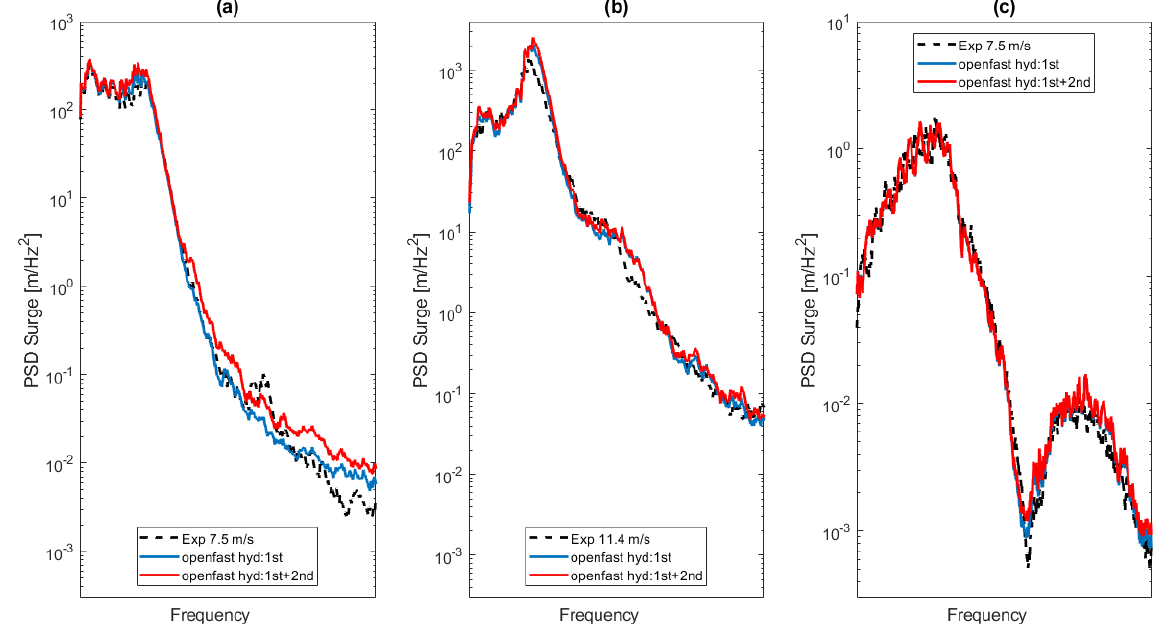
Figure 11. Surge PSD response of SATH 10MW under (a) turbulent wind with average of 7.5ms − 1 and irregular waves with H s = 2 . 0m and T p = 8 . 5s, (b) turbulent wind with average of 11.4ms − 1 and irregular waves with H s = 3 . 0m and T p = 10 . 5s, and (c) wave region for turbulent wind with average of 7.5ms − 1 and irregular waves with H s = 2 . 0m and T p = 8 . 5s.